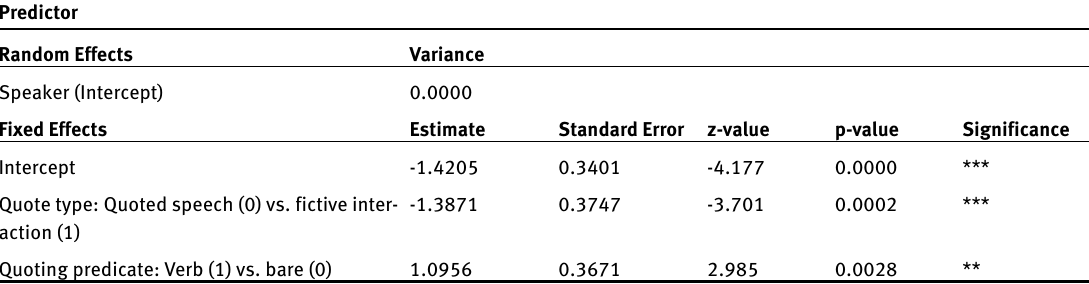
Table 12: The best generalized mixed-effects regression model for initial utterances in Quoted Dialogue sequences. Only predictors for the best-fit model are shown. Negative estimates indicate lower probability. Significance is indicated as